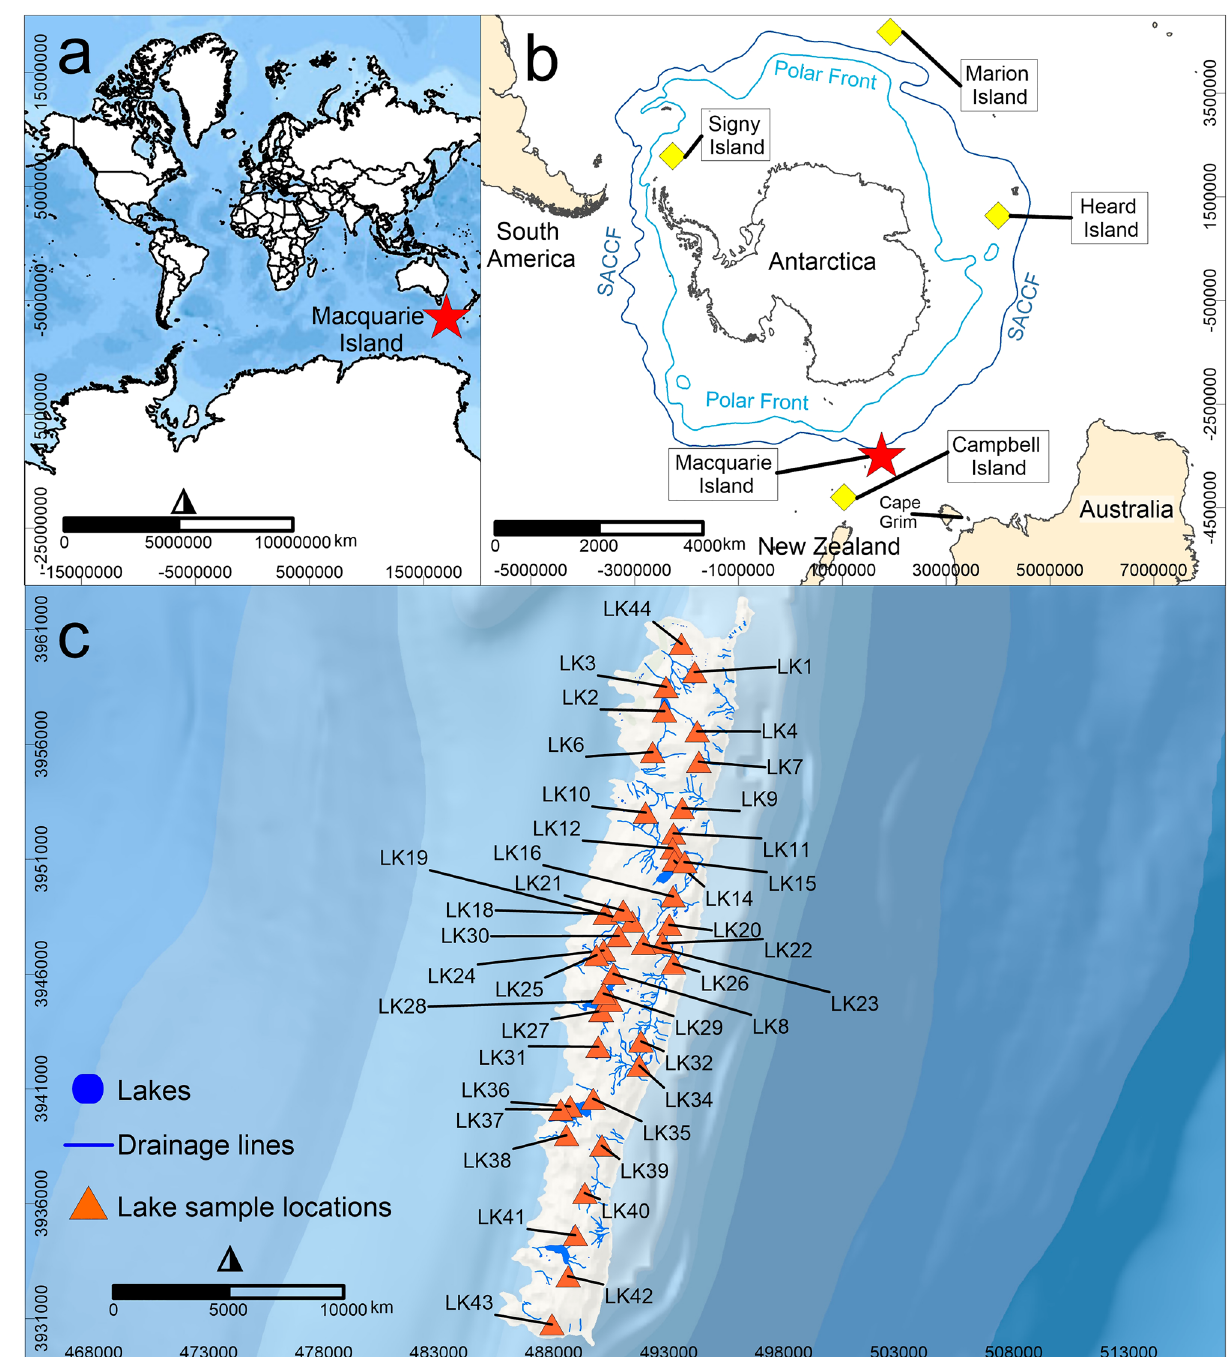
Figure 1. ( a ) The global context of the study area showing the location of Macquarie Island (indicated by a red star), map uses WGS84 coordinate system ( b ) the location of Macquarie Island (indicated by a red star) with respect to Antarctica, Australia and South America and the SOIs (Southern Ocean Islands), Polar Front and Southern Antarctic Circumpolar Current Front (SACCF), map uses the Polar Stereographic coordinate system, and ( c ) map of Macquarie Island with location of lake water sampling sites (orange symbols) with lake extents and drainage